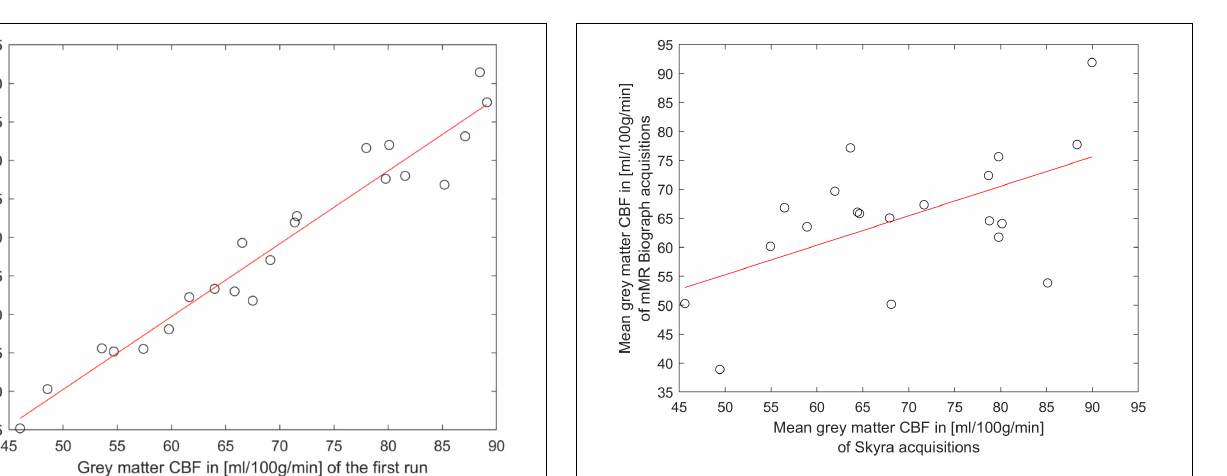
FIGURE 4 | Excellent reliability of pCASL acquisitions at the Skyra: CBF values for the gray matter region-of-interest of the first and the second run of the same session is shown for every participant (circles). The straight red line represents a linear fit of these values.